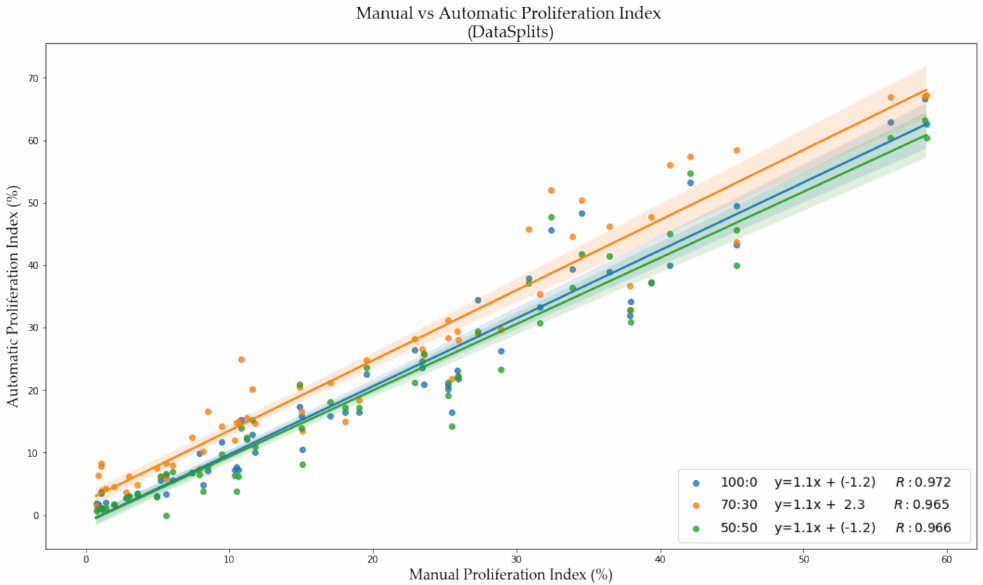
Figure 13. PI scatter plot of manual PI vs. automated PI for each data split experiment, with the corresponding Pearson Coefficient (R), and equation of the line.